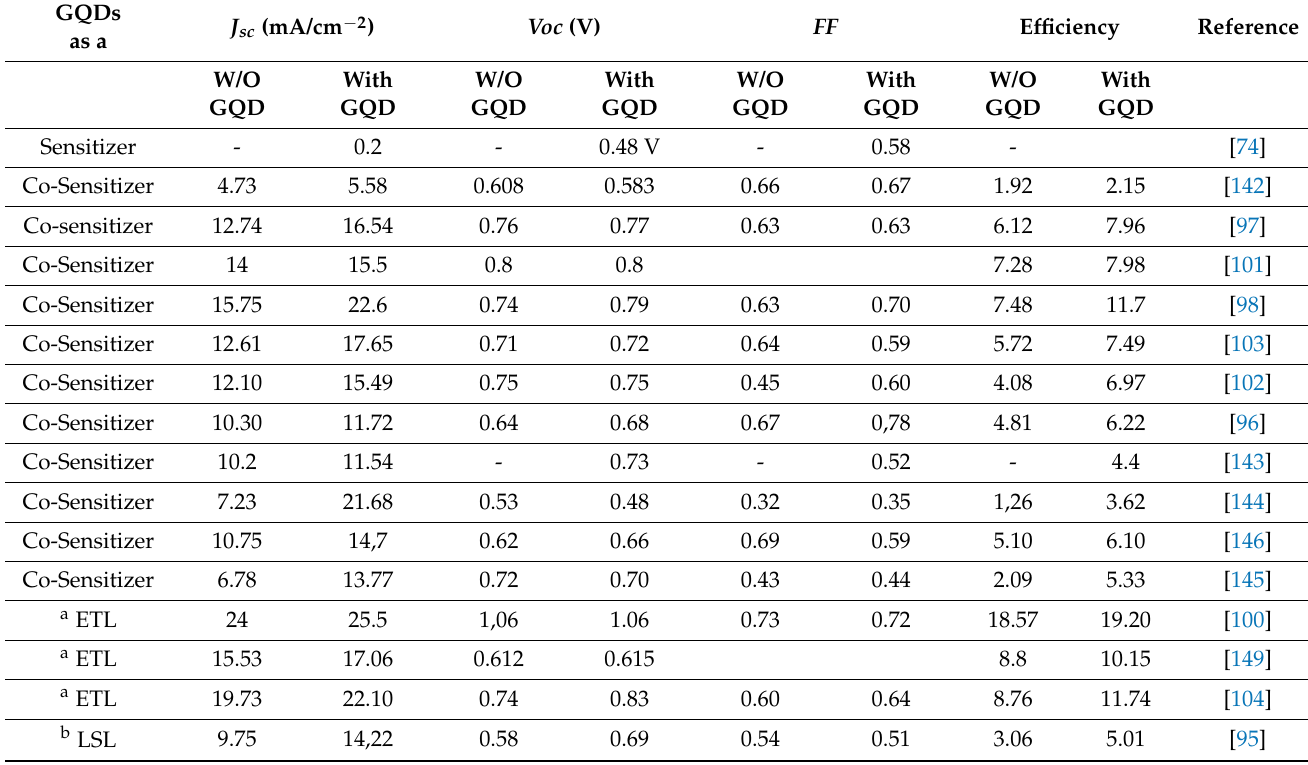
* The data in the table represent the best results obtained in the reference. a = electron-transporting layer, b = light-scattering